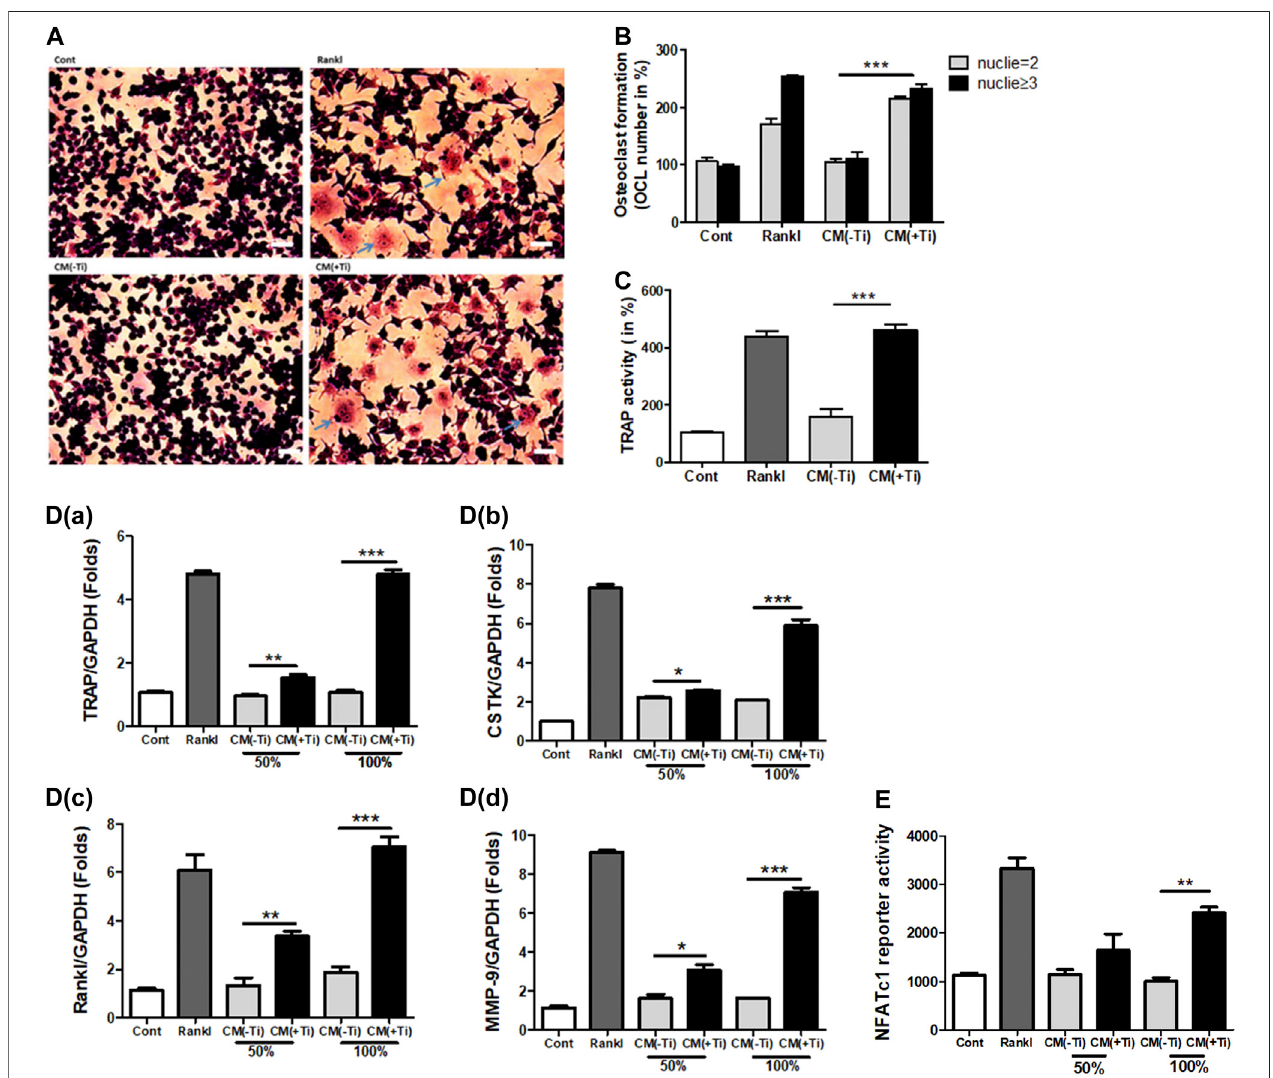
FIGURE2| TiCMinducedosteoclastogenicdifferentiationinRaw264.7cells. (A) TRAPstainingofosteoclasts(100 × ),osteoclastformation,andmorphologywere observed by light microscopy. (B) The number of TRAP-positive cells with two or more nuclei was counted after 9 days of Ti CM or Rankl (50 ng/mL) treatment of Raw 264.7 cells.Rankltreatmentistakenasapositivecontrol. (C) Quanti fi cation ofTRAPactivity. D(a – d) TiCMinducedtherelative mRNAexpression ofosteoclastmarkers (TRAP, Rankl, MMP-9, and CSTK) after 9 days of Ti CM or Rankl treatment of Raw 264.7 cells. (E) NFATc1 reporter plasmid was transiently transfected to Raw 264.7 cells. The Ti CM treatment was done for 24 h, and reporter activity was analyzed from the cell lysate. Rankl treatment is taken as a positive control. Data are expressed as mean ± SD. n (cid:2) 3. * p < 0.05, ** p < 0.01, and *** p < 0.001 vs. control.